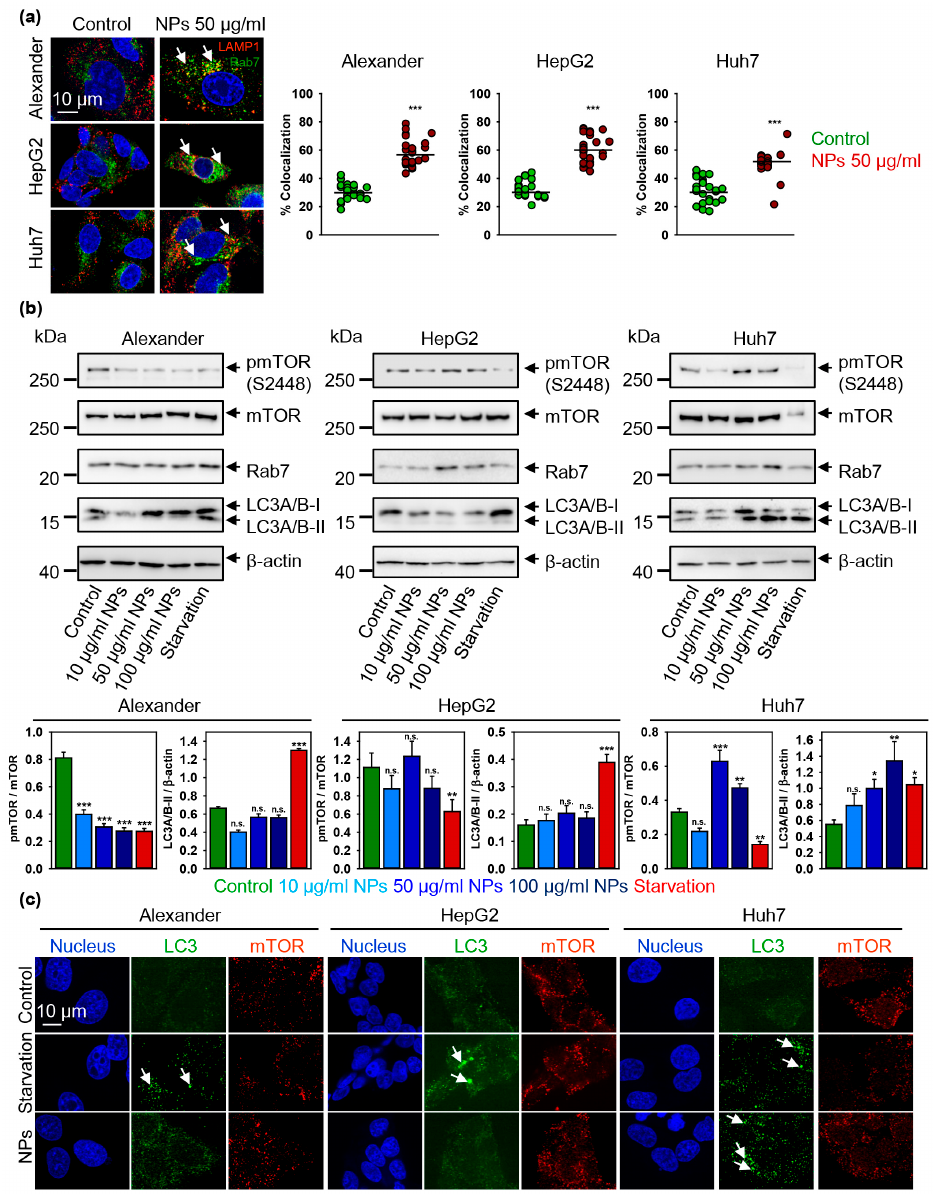
Figure 6. Nanoparticle treatment-induced autophagic flux is cell line dependent. ( a ) Colocalization analysis of nanoparticles and Rab7 protein. Cells were treated for 12 h with nanoparticles 50 µ g Fe mL − 1 , fixed and immunostained for LAMP1 (red) and Rab7 (green). Labeled cells were then imaged using spinning disk confocal microscopy. Colocalization quantifications were done in ImageJ and presented as means of n = 25 cells. (***) p < 0.001 denotes significant differences with respect to control (no particles treatment). ( b ) Cells were stimulated with nanoparticles at indicated concentrations for 12 h. Expressions of pmTOR, mTOR, Rab7 and LC-3 were analyzed by immunoblotting. Positive control—serum starvation for 12 (Alexander, Huh7) and 14 (HepG2) h. Actin denotes loading control. Graphs show densitometric quantification of blots. (*) p < 0.05, (**) p < 0.01 and (***) p < 0.001 denotes significant differences with respect to control (no particles treatment). ( c ) Confirmation of autophagic flux by formation of cellular autophagosome punctae containing LC3-II. Cells were treated for 12 h with nanoparticles 50 µ g Fe mL − 1 , fixed and immunostained for mTOR (red) and LC3 (green). Labeled cells were then imaged using spinning disk confocal microscopy. Arrows indicate formation of cellular autophagosome punctae. Positive control—serum starvation for 12 (Alexander, Huh7) and 14 (HepG2) h. Nuclei were stained with Hoechst